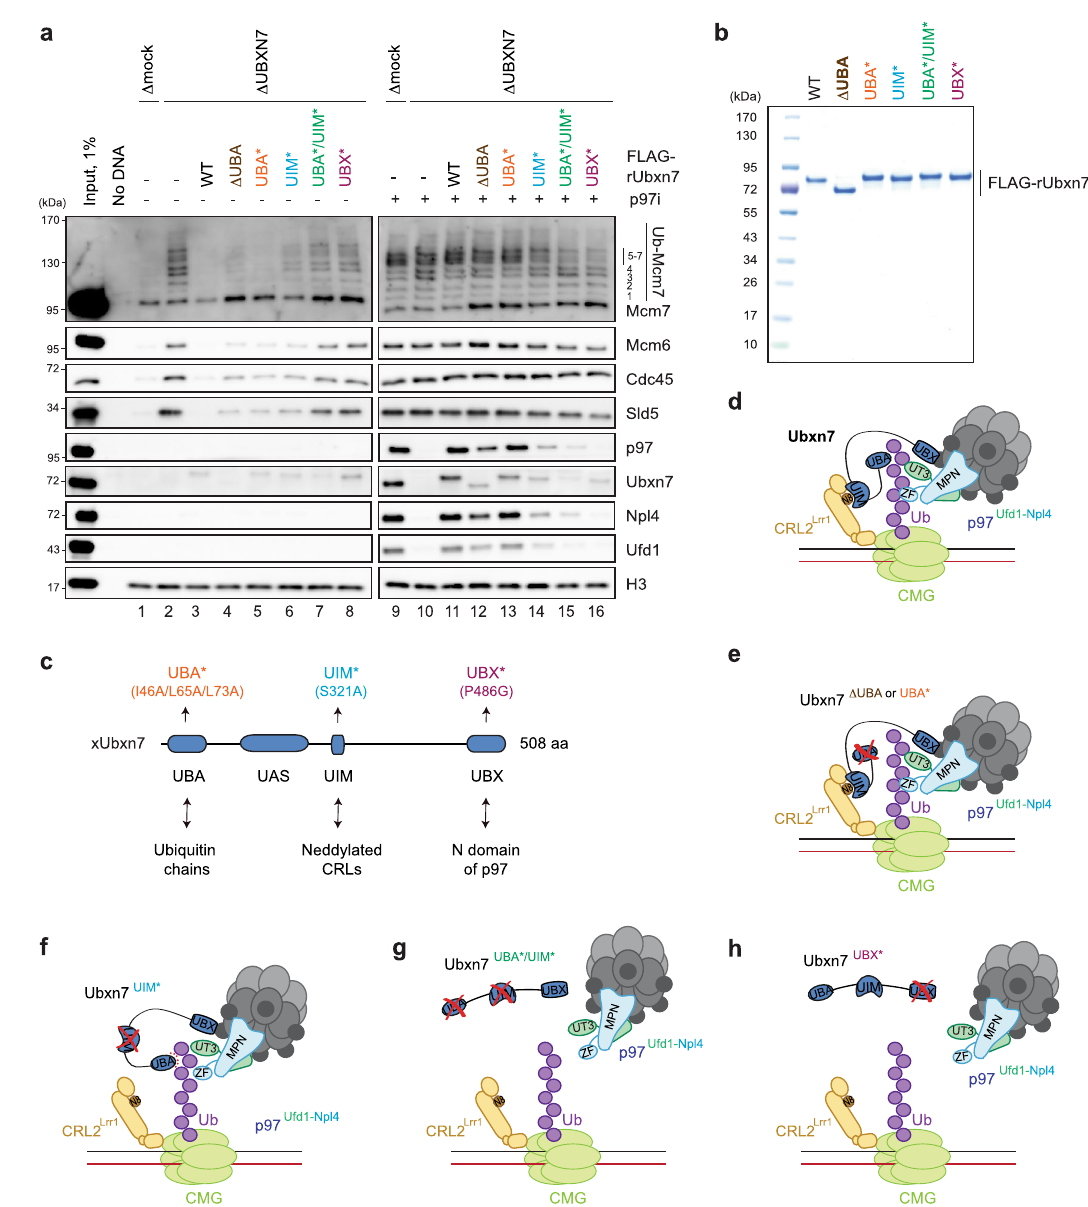
N8 Nedd8, red dotted lines indicate weak protein – protein interactions. Source data are provided as a Source Data fi